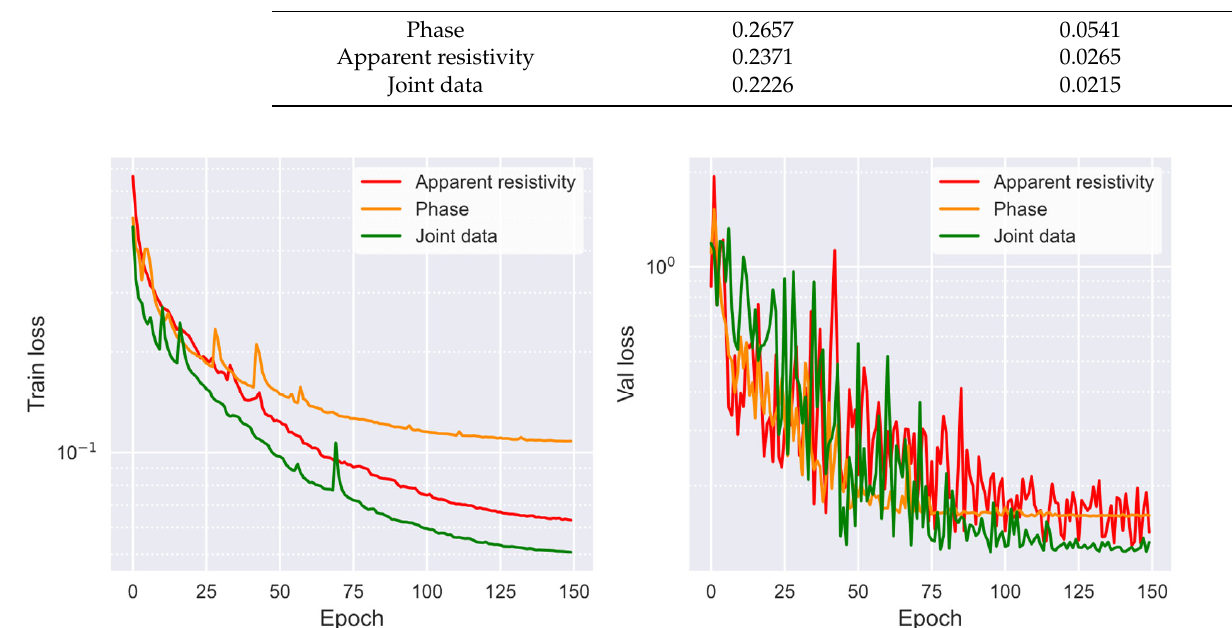
Figure 10. The training and validation convergence curves of PhyDNN for the apparent resistivity, phase and joint data.